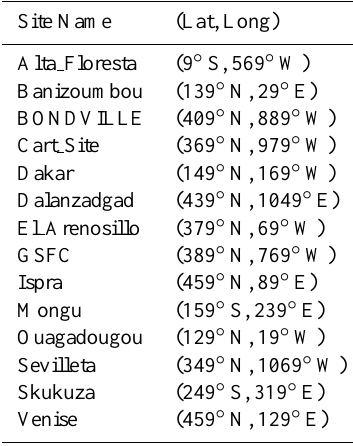
Table 3. AERONET sites with long-term records used for time series